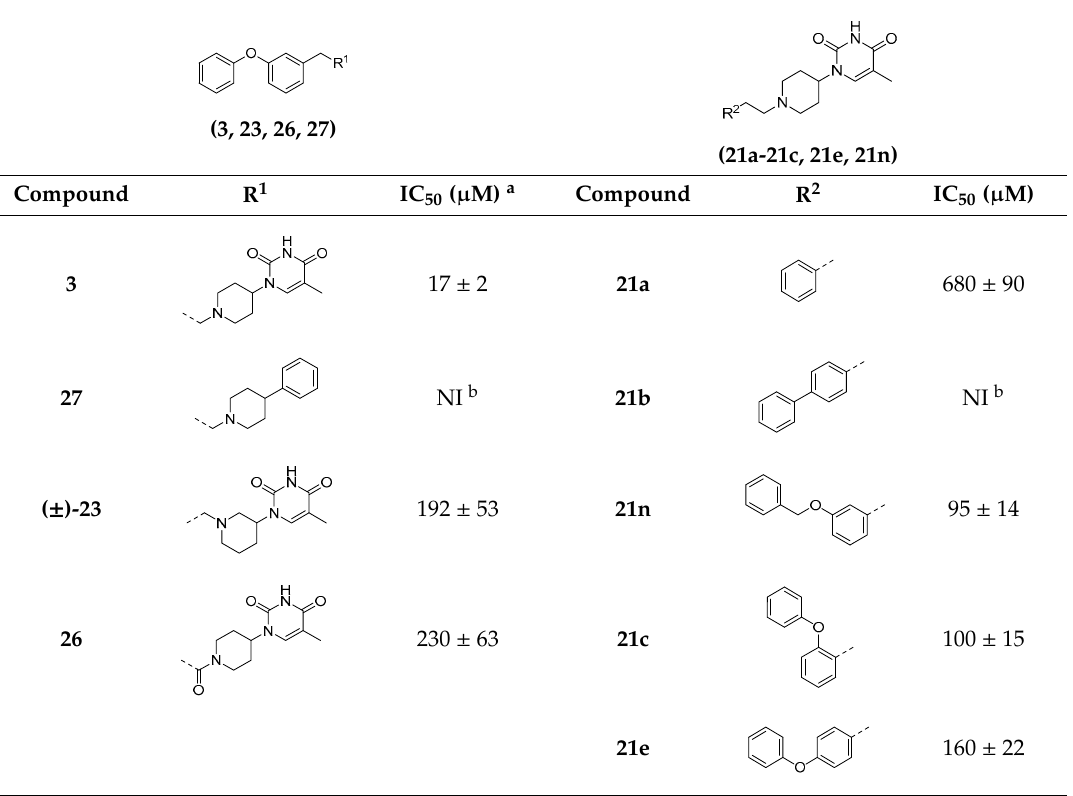
Table 1. Mycobacterium tuberculosis TMPK (Mtb TMPK ) inhibitory potency of the compounds.